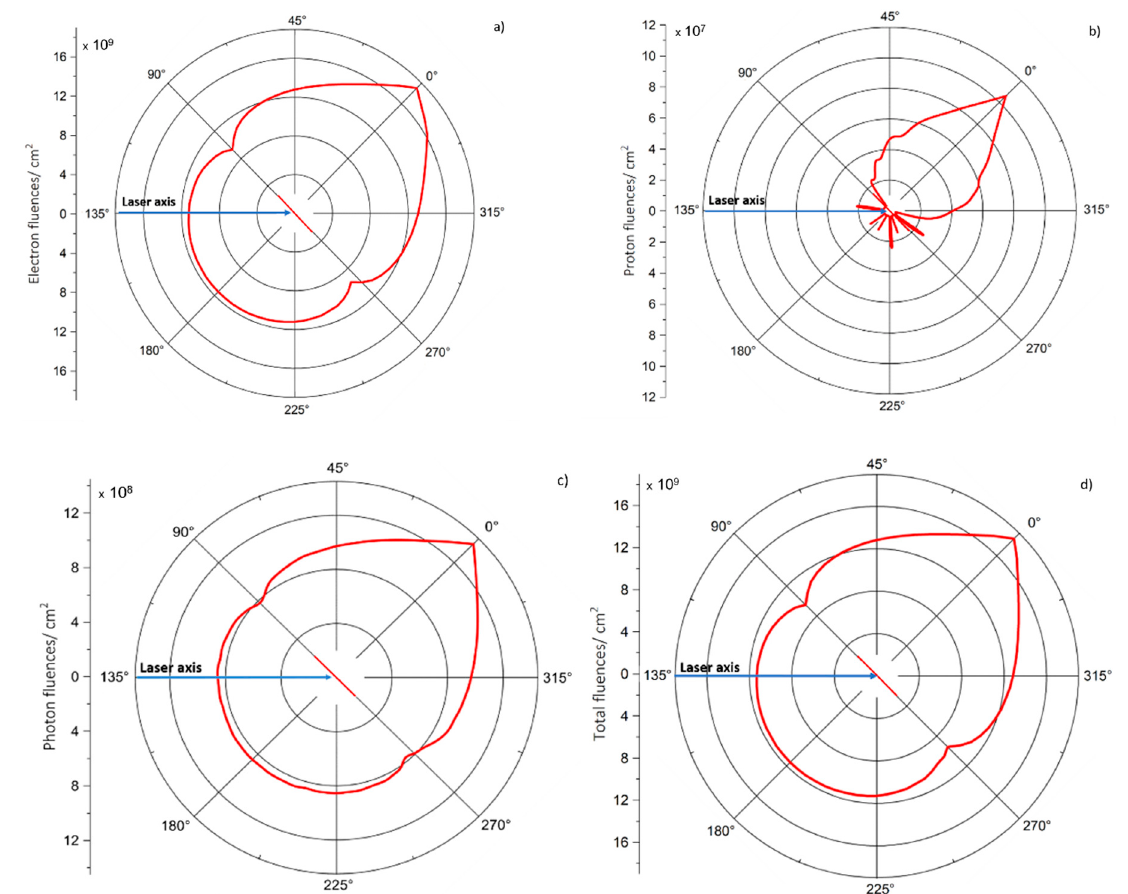
Figure 6. Angular dependence of particle fluencies / cm 2 at 3 cm from the interaction point on logarithmic scale: ( a ) electrons ( b ) protons ( c ) photons and ( d ) total fluencies. (c) Simulated and Experimental Dose Maps